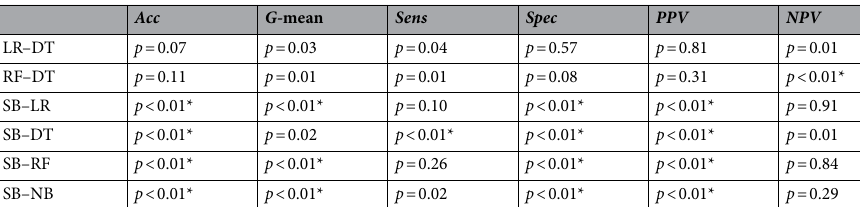
Table 3. Pairwise comparisons tests among different classification methods, and between these and SB criteria, regarding the several OC. Acc accuracy, Sens sensitivity, Spec specificity, PPV positive predictive value, NPV negative predictive value, LR logistic regression, DT decision tree, RF random forest, NB naive Bayes Non reported pairwise comparisons did not present any significant difference for p < 0.05. *Still significant for p < 0.05 after applying Bonferroni correction for multiple